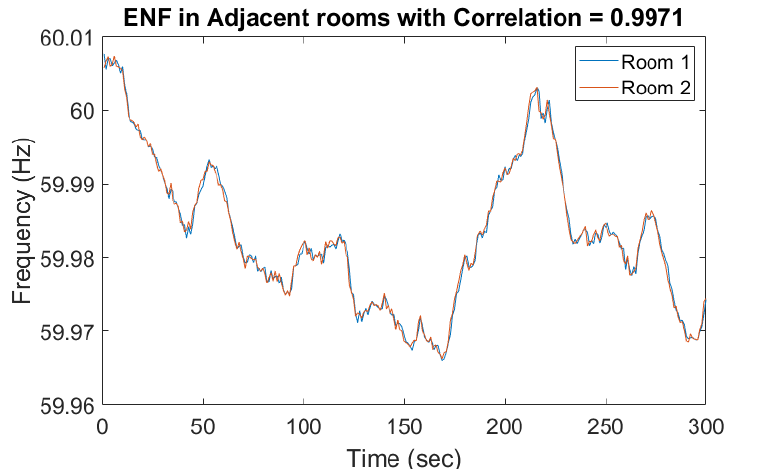
Figure 3. Electrical Network Frequency (ENF) captured in adjacent rooms.